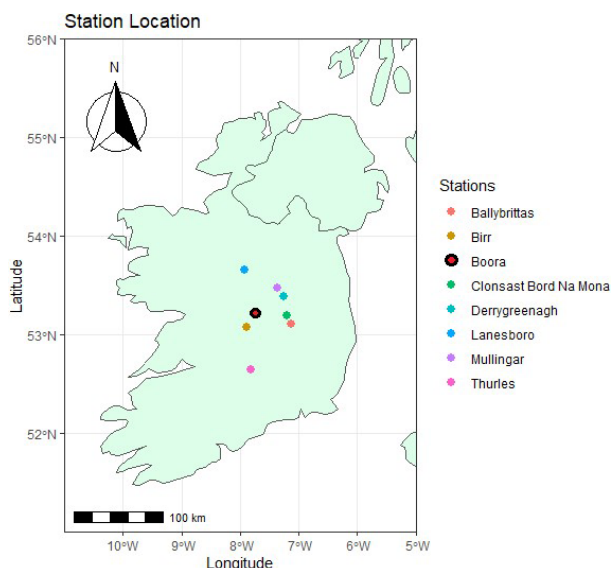
Figure 13. Map of stations closest to Boora considered in this anal-